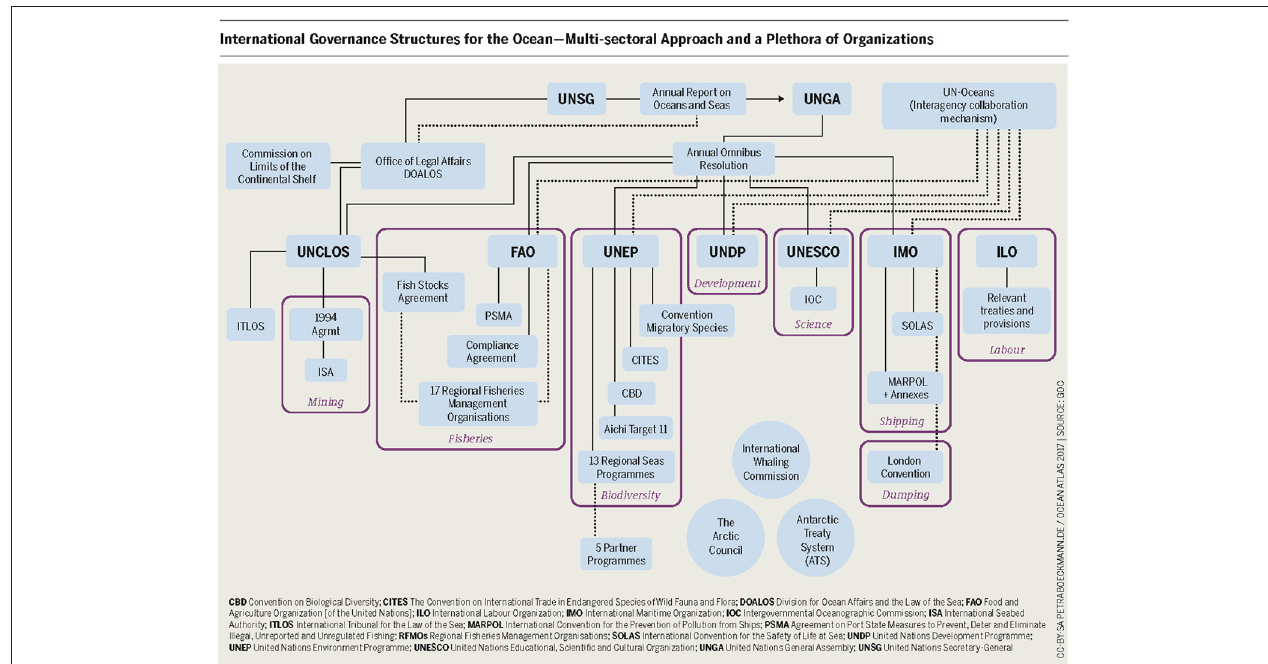
FIGURE 5 | UN Mandates for Ocean-Related Activities (UN Ocean Structure Atlas, 2017) 9